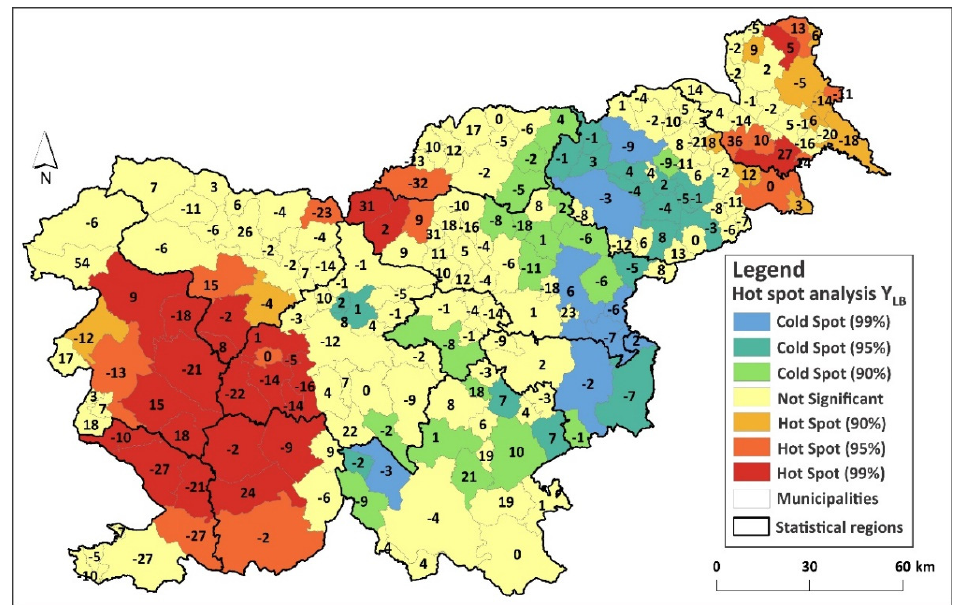
Figure 5. CART-predicted LB hot and cold spots. The numbers represent the deviations (residuals) of the predicted Y LB from the actual Y LB .